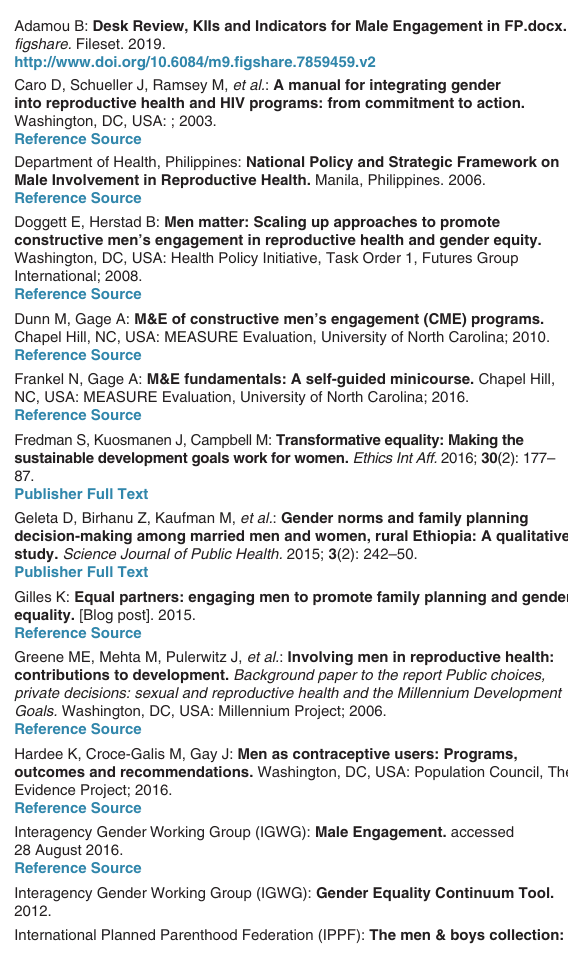
Figshare: Desk Review, KIIs and Indicators for Male Engage- ment in FP.docx. https://doi.org/10.6084/m9.figshare.7859459.v2 (Adamou,